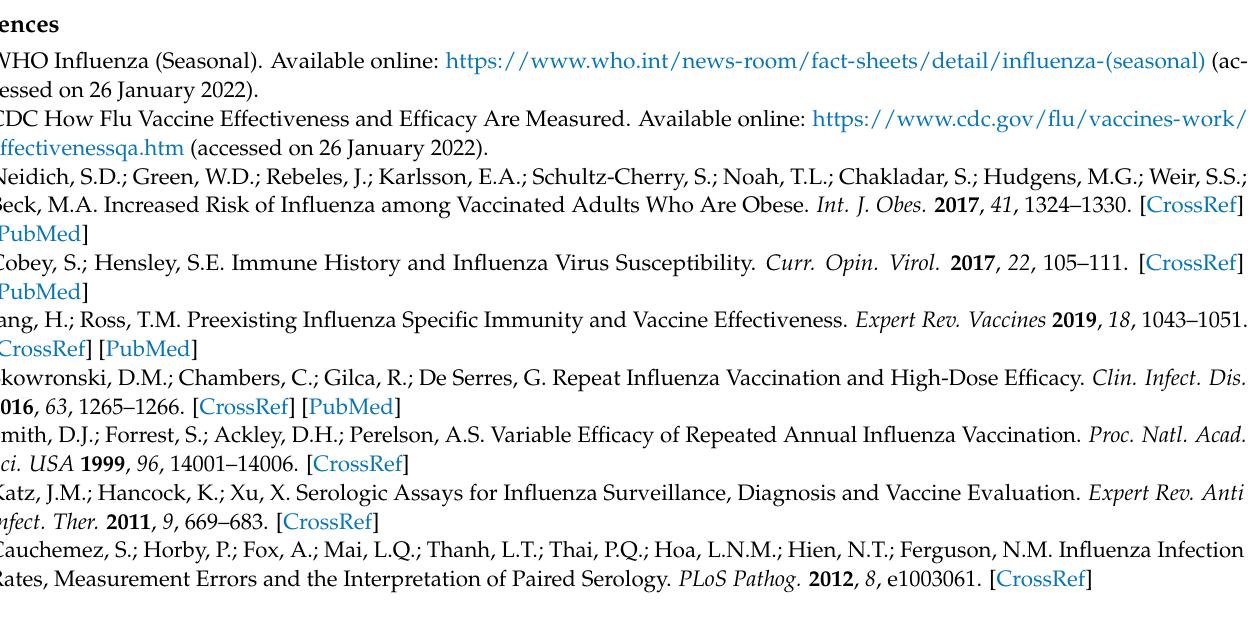
component; Table S1: UGA4 study participant information, Table S2: Gene counts for each study participant obtained from RNAseq performed on whole blood, Table S3: Univariate differential gene expression analysis of baseline HAI, Table S4: Univariate differential gene expression analysis of seroconversion, Table S5: Bivariate differential gene expression analysis of baseline HAI and BMI, Table S6: Bivariate differential gene expression analysis of seroconversion and